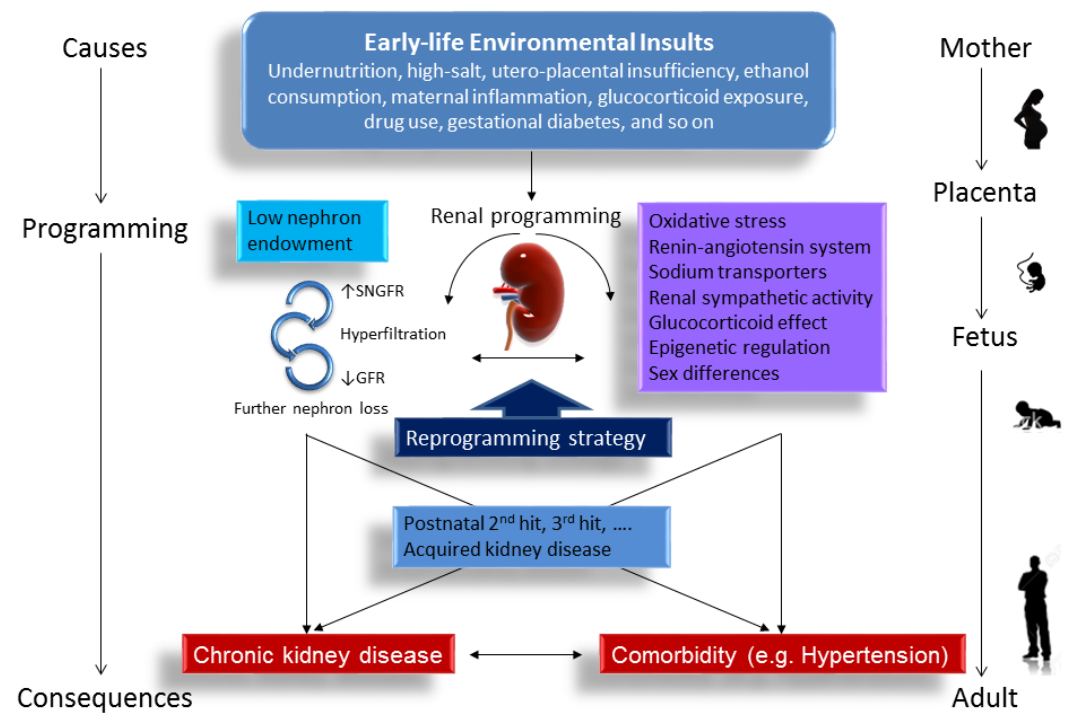
Figure 1. Schema outlining the early-life insults that induce renal programming and increase the vulnerability to later superimposed renal injury, leading to chronic kidney disease (CKD) and related comorbidity in later life. CKD can be attributed to multiple hits. A variety of early-life environmental insults (e.g., undernutrition) can cause renal programming, which is associated with low nephron endowment and other molecular mechanisms (e.g., oxidative stress). Renal programming likely constitutes a first-hit to the kidney which makes the kidney more vulnerable to postnatal insults (i.e., 2nd hit) to develop CKD in later life. The blue arrowhead indicates the application of reprogramming strategies in early life may prevent the developmental programming of kidney disease. SNGFR = single nephron glomerular filtration rate. GFR = glomerular filtration rate.